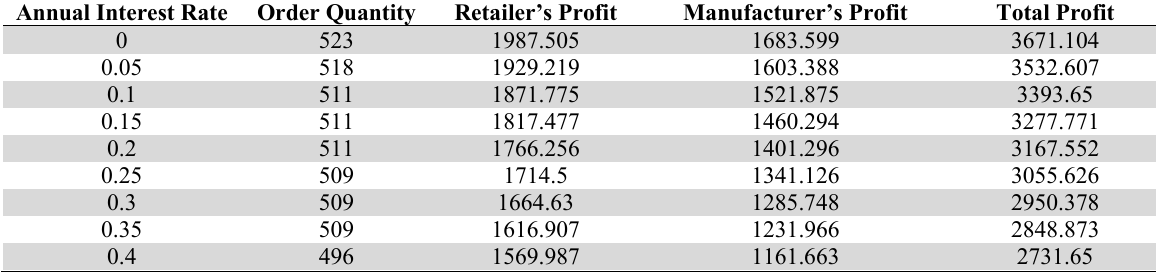
Annual Interest Rate Order Quantity Retailer’s Profit Manufacturer’s Profit Total Profit 0